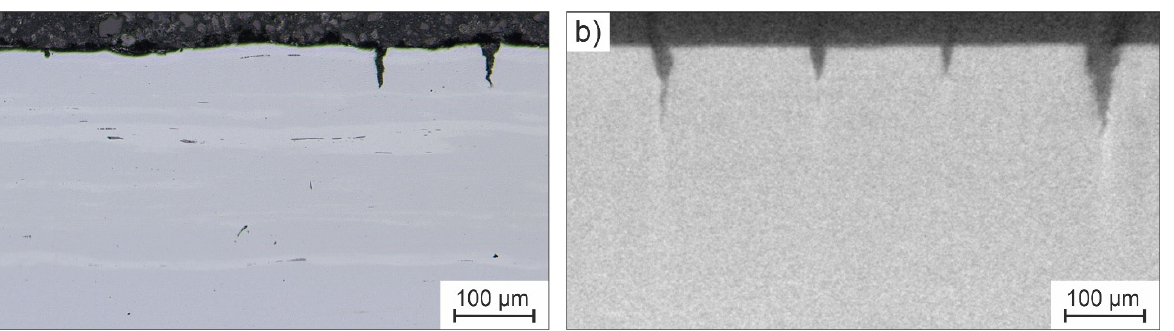
Figure 10. The appearance of secondary cracks in the X2CrNi18 ‐ 9 steel in ( a ) a light microscopic image and ( b ) a CT ‐ slice